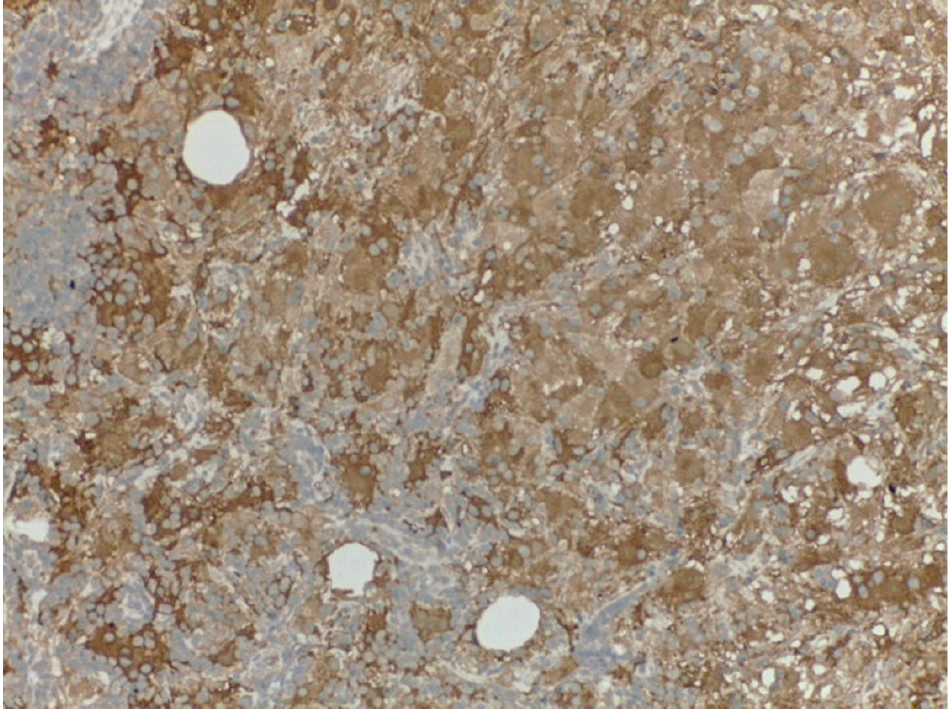
Figure 4. Rosai–Dorfman disease of the breast: immunohistochemistry—S100 diffuse positive histiocytes (20×).